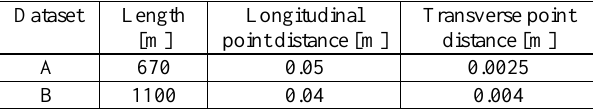
Table 1. Characteristics of the datasets